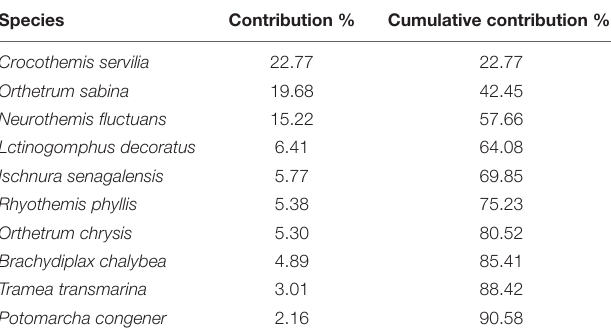
TABLE 4 | Odonata species that together composed over 90% of the assemblages (based on abundance) observed in sampled oil palm waterways.